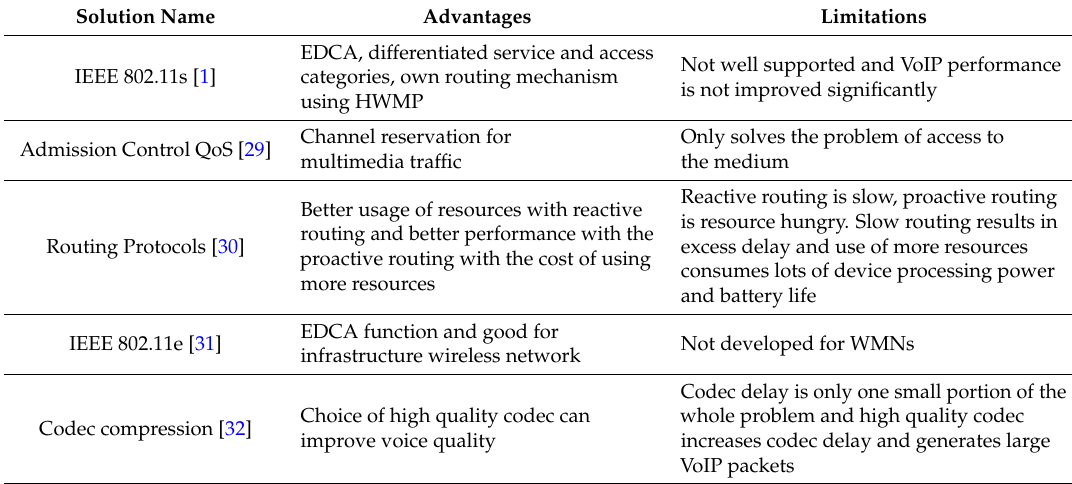
Table 1. Advantages and limitations of existing QoS solutions for VoIP over